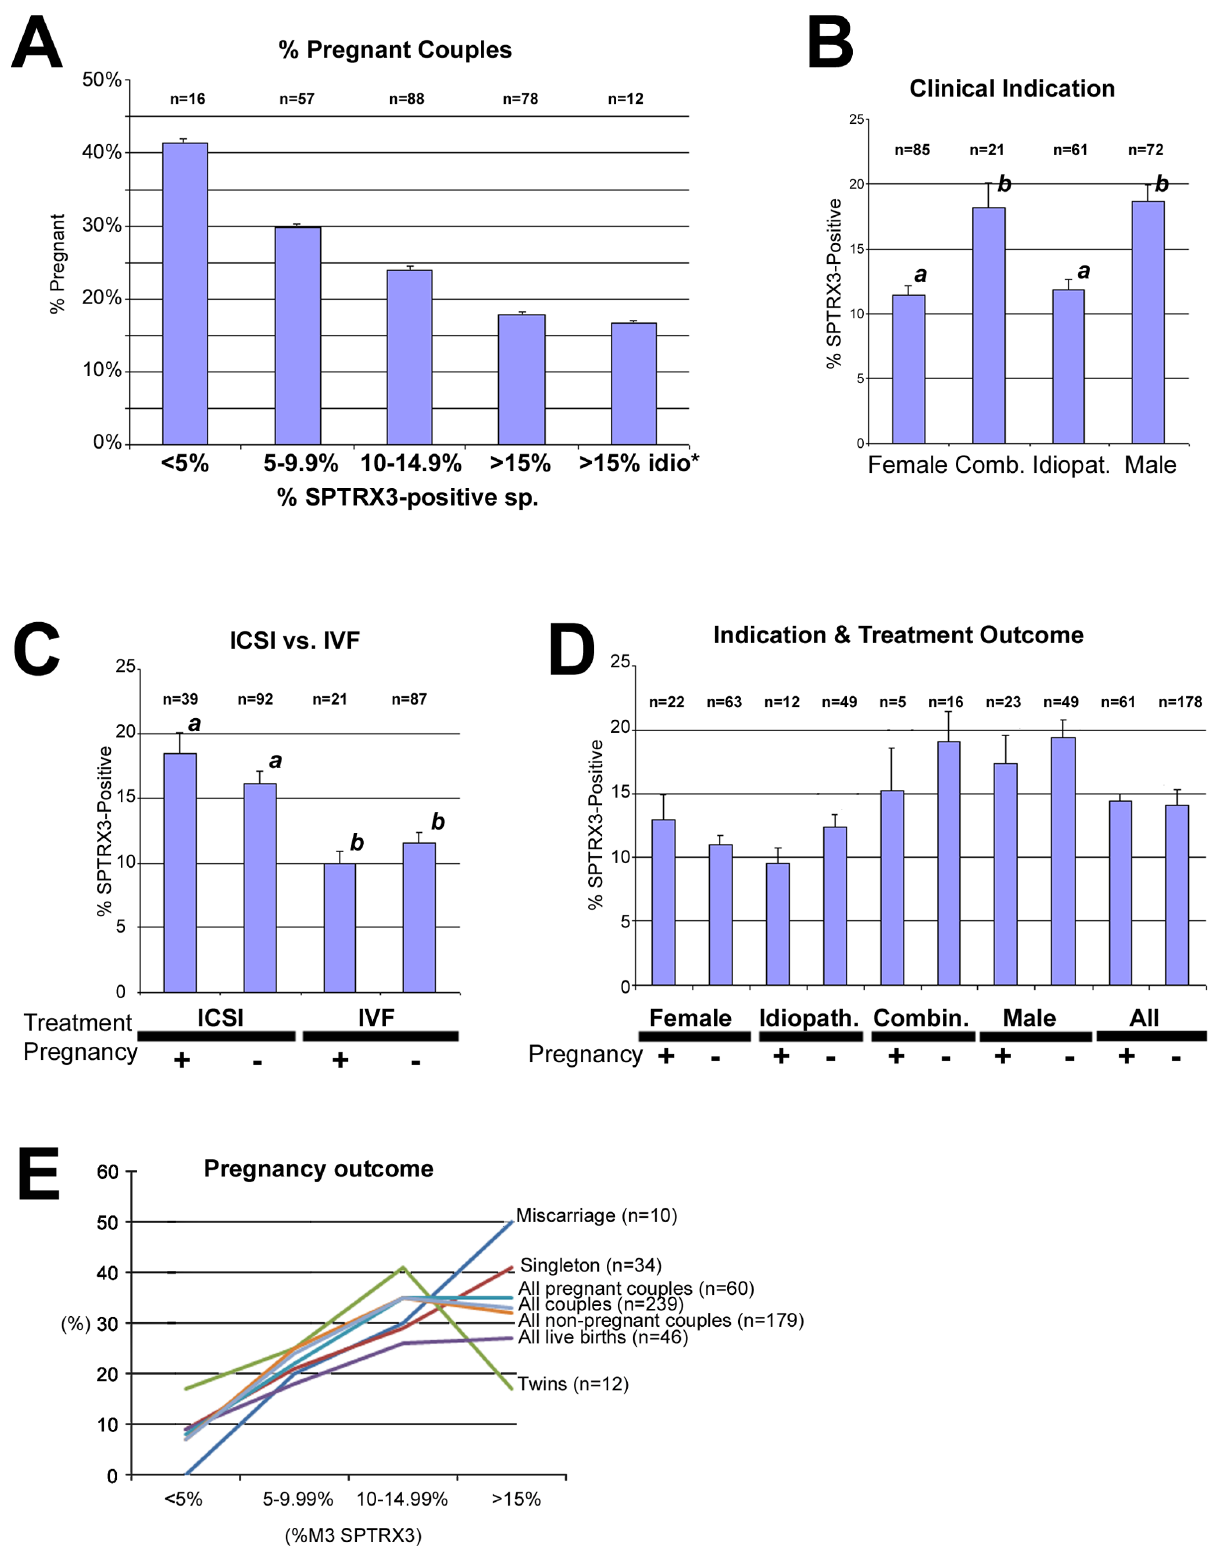
Figure 2. Diagrams of average SPTRX3 content in spermatozoa of men from 239 infertile couples. ( A ) Average pregnancy rates after infertility treatment (IVF or ICSI) decreased gradually with the increased sperm SPTRX3-content in 239 couples divided by % of SPTRX3 spermatozoa (flow cytometric %M3 value; x-axis) into subgroups with less than 5%, 5–9.99%, 10–14.99%, and more than 15% of SPTRX3-positive spermatozoa. Compared to men with less than 5% SPTRX3-positive spermatozoa, those carrying more than 15% of such cells had their chance of conceiving reduced by a half (41.2% pregnant, vs. 19.2% pregnant; one-sided p , 0.05). ( B ) Low levels of sperm SPTRX3 were found in female and idiopathic